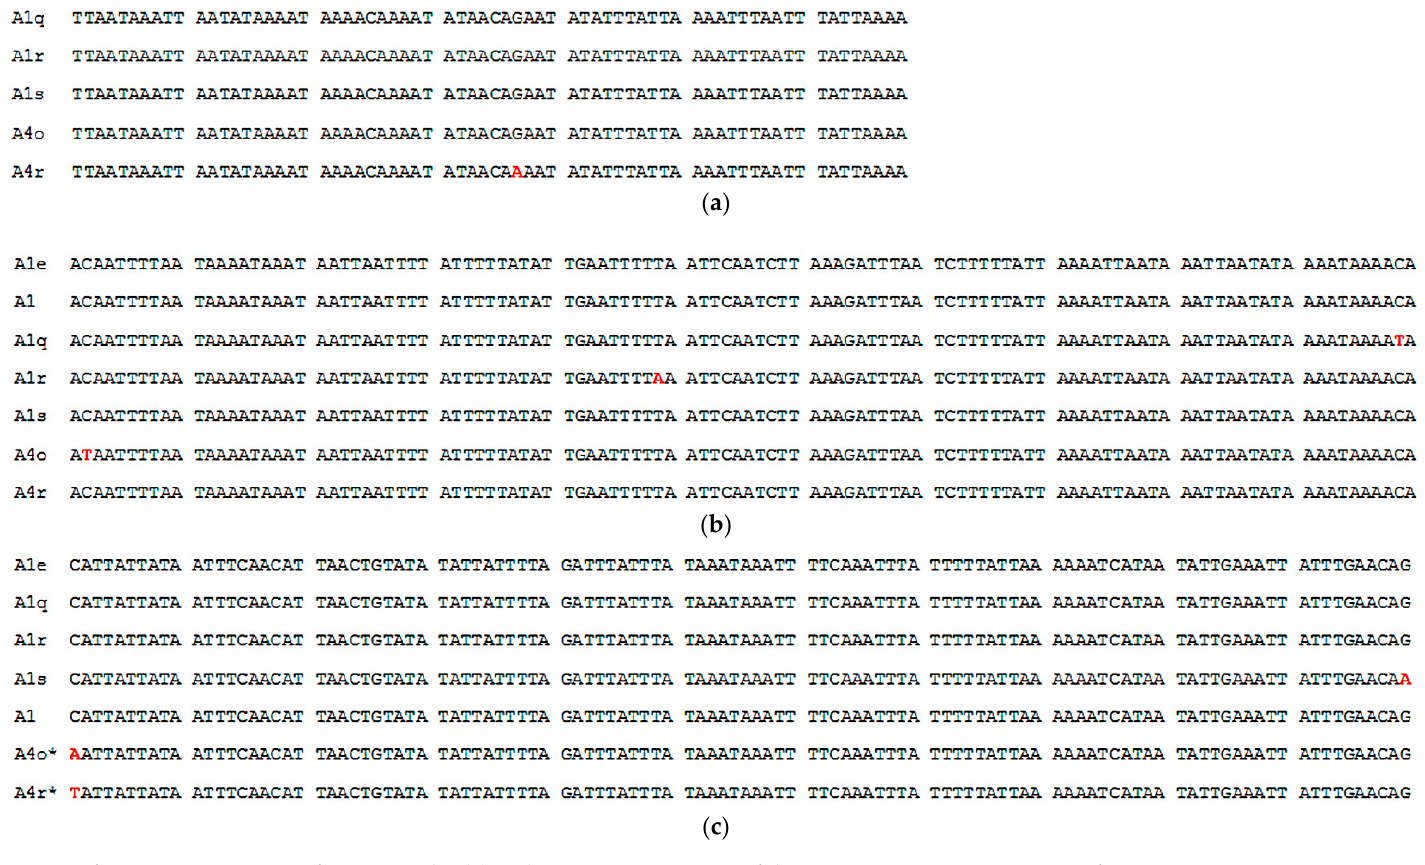
Figure 3. Pattern of P 0 sequences section from 1 to 68bp ( a ) and Q sequences section of the COI – COII intergenic region of A 1 , A 1e , A 1s , A 1q , A 1r , A 4o , A 4r from 69 to 218 bp ( b ) and from 339 to 468 bp ( c ). Asterisk (*) mark indicates 2nd Q section of A 4o and A 4r from 459 to 589 bp. Letters in red correspond to mutation